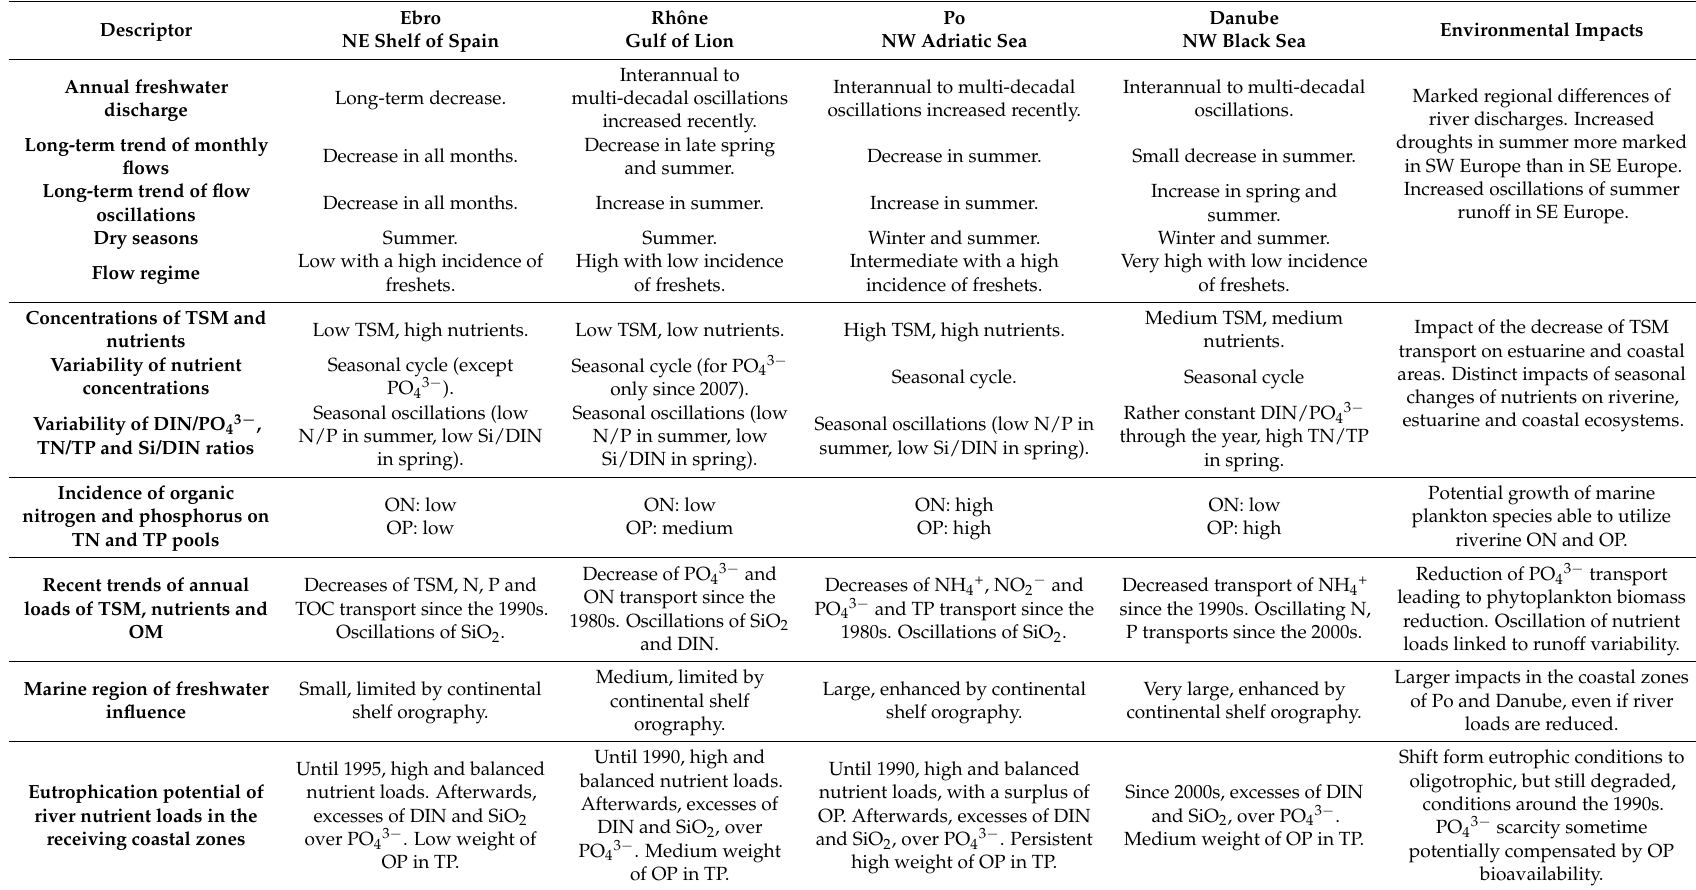
Table 4. Summary of the descriptors analyzed in this study and of the potential impacts in the adjacent coastal zones discussed in the Sections 4.1 and